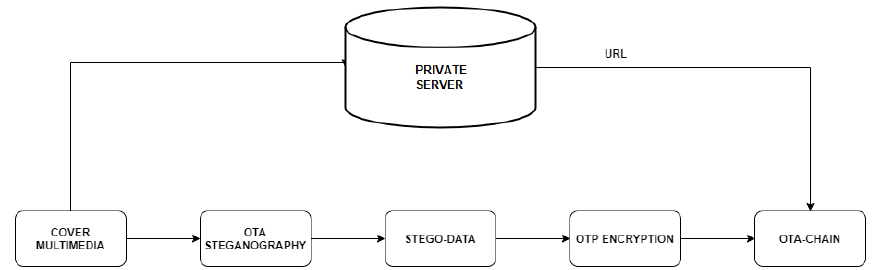
Figure 2. Architecture of OTA Steganography.